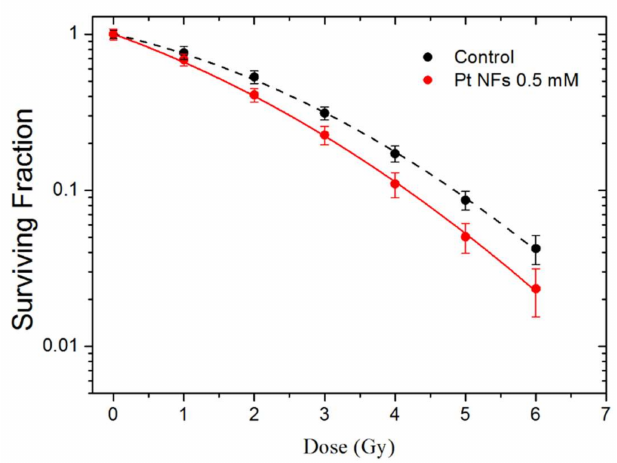
Figure 8. Surviving Fraction (SF) of HeLa cells irradiated by γ rays, in the presence of Pt NFs (red) and in the control (black).